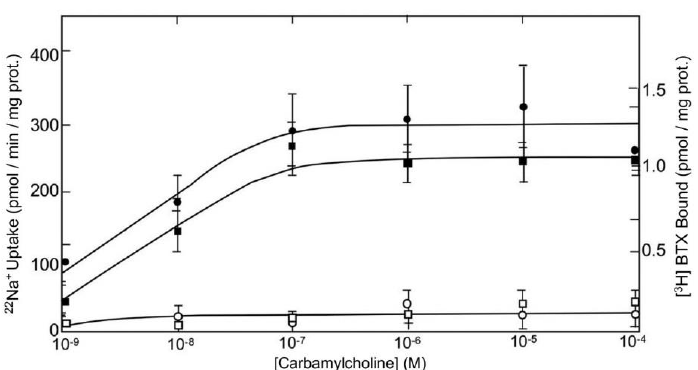
Figure 1. TTX-blockable 22 Na + uptake (circles) and [ 3 H]BTX binding (squares) to pertussis toxin- treated synaptoneurosomes, as a function of carbamylcholine concentration in the presence ( , ) and absence ( , ) of atropine (0.1 µM). The specific carbamylcholine-induced binding of [ 3 H]BTX was measured in the presence of TTX (1 µM). The non-specific carbamylcholine-induced 22 Na + up-